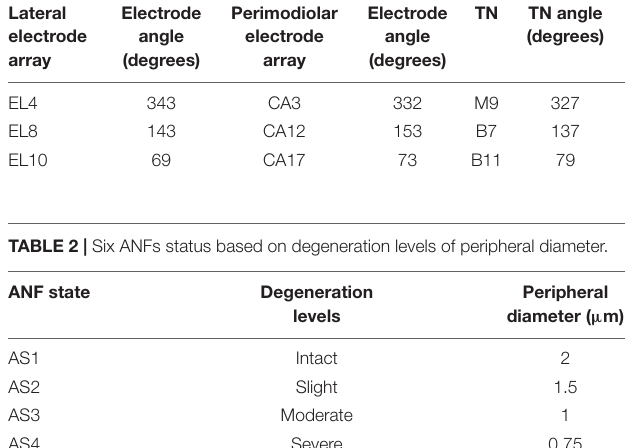
FIGURE 2 | Investigated asymmetric and symmetric pulse shapes. (A) Monophasic, (B) Pseudo-monophasic, (C) Triphasic, and (D) Biphasic pulse. Blue and red colors represent the cathodic and anodic phases,